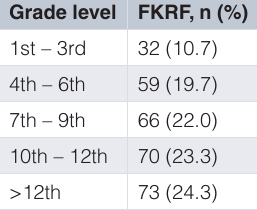
Table 3. Tweet material grade level summary by